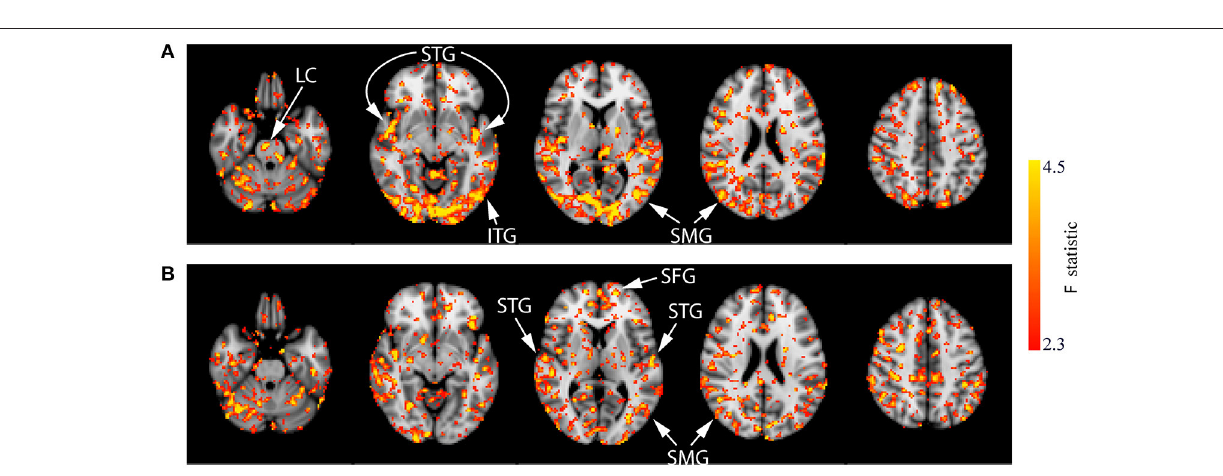
FIGURE 6 | Results of the one-way ANOVA demonstrating the main effect of session for the CON (A) and ACT 1mA (B) groups. Axial slices are taken from MNI coordinates z = − 26, − 8, 6, 22, and 44mm (left to